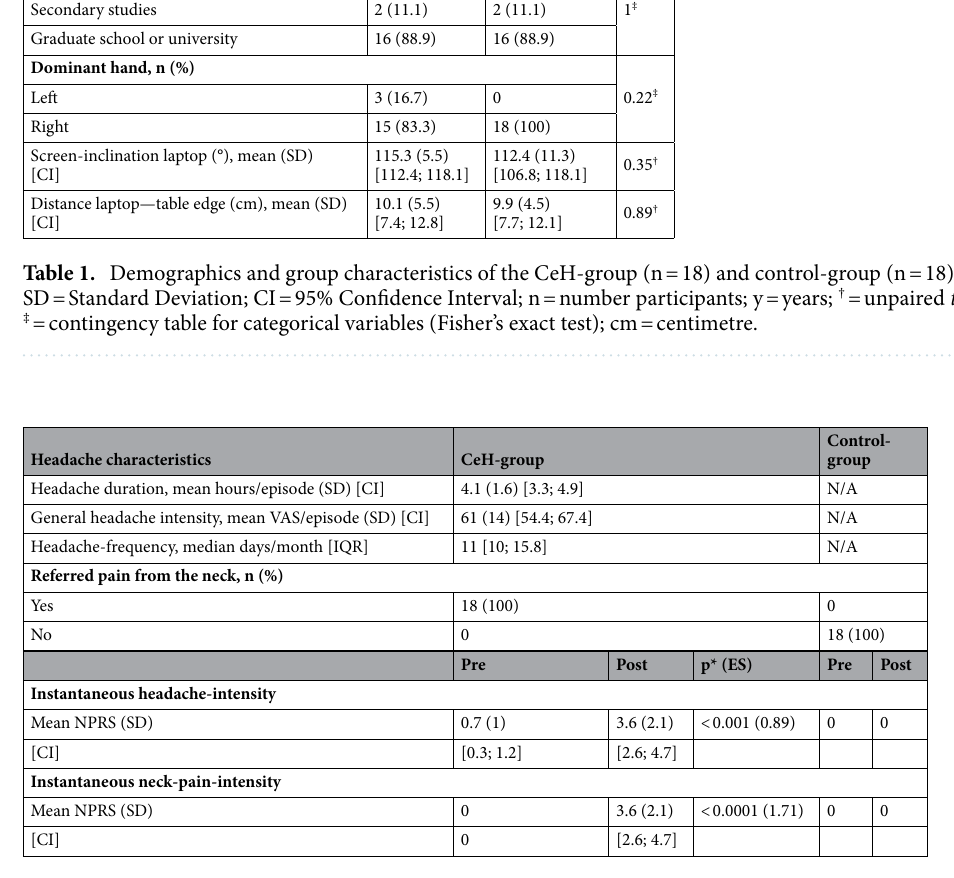
Table 2. Headache characteristics of participants with CeH (n = 18) and healthy controls (n = 18). n = number participants; SD = Standard deviation; CI = 95% Confidence interval; VAS = 100 mm Visual analogue